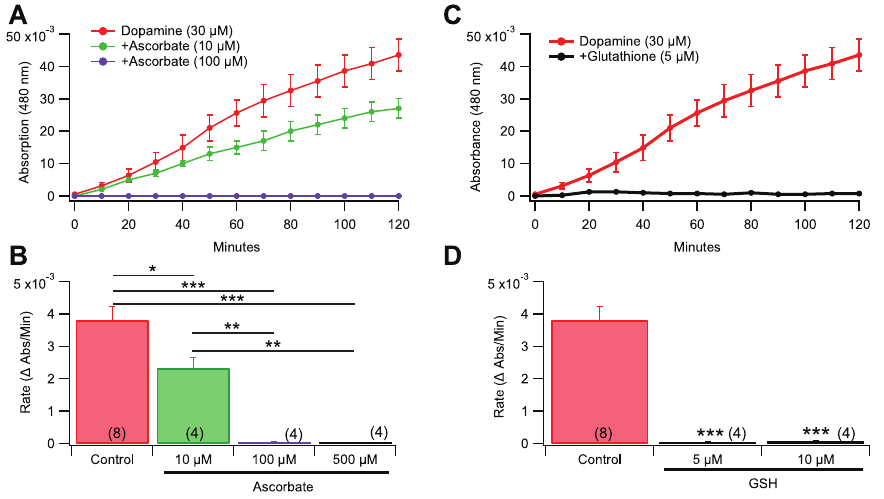
Figure 4. E ff ects of anti-oxidants on melanogenesis of DA. ( A ) Concentration response demonstrating that increased ascorbic acid (ASC) concentrations reduce and block DA melanogenesis. ( B ) Ascorbate significantly reduced the rate of DA melanogenesis. melanogenesis. Note that these concentrations are three orders of magnitude lower than those of ASC, and much lower than GSH levels normally seen in cells. ( D ) Glutathione significantly reduced the rate of DA melanogenesis. Values in parentheses represent n values. Asterisks *, **, *** indicate significance level p < 0.05, p < 0.01 and p < 0.001 respectively. Data is presented as mean ±